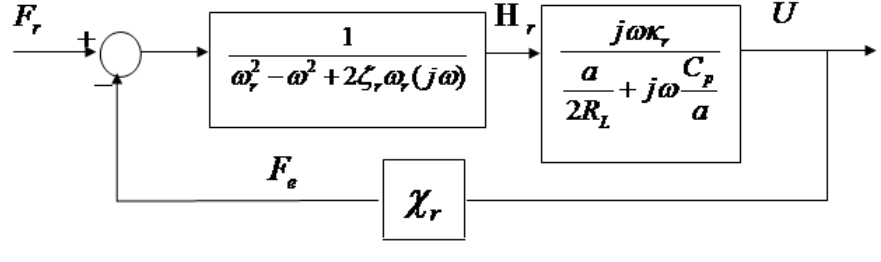
Figure 3. Block diagram for response around r th mode of the parallel (a = 1) and series (a = 2) connected piezoelectric